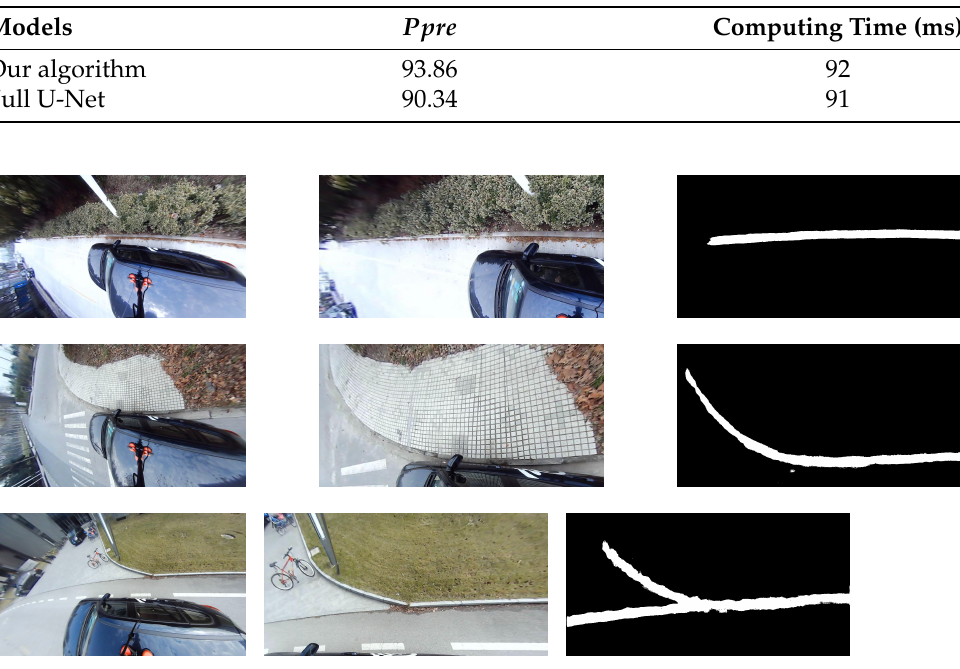
Figure 3. Detection results of deep curb detection network. Left column: image samples from the dataset; Middle Column: enlarged curb regions of interests extracted by CRoI module; Right column: curb segmentation results.